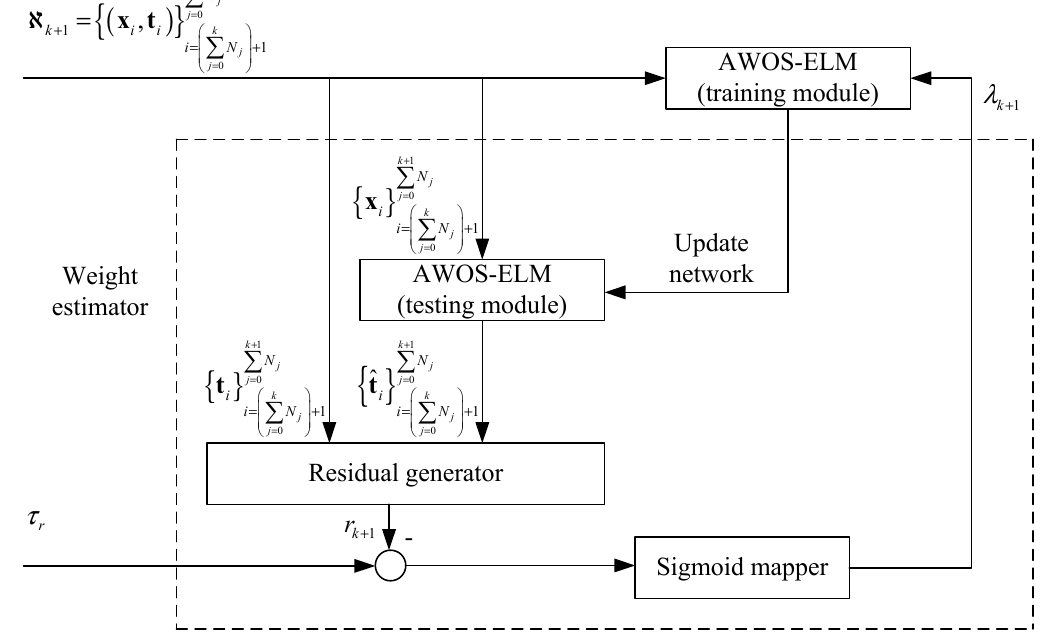
Figure 1. Block diagram of the adaptive weight online sequential extreme learning machine (AWOS-ELM) algorithm.